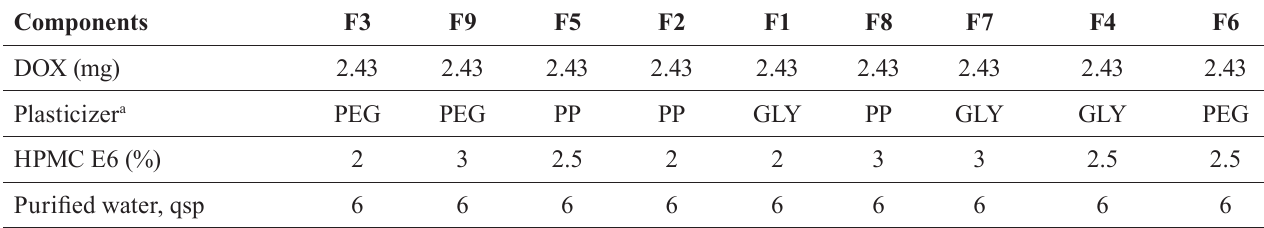
TABLE I - C omposition of orodispersible films according to the design of experiments (DoE)